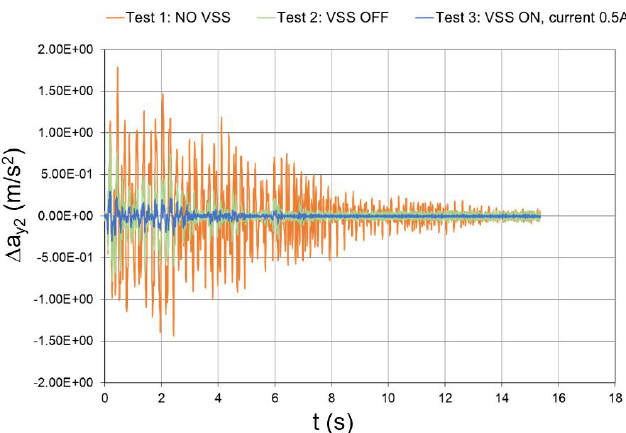
Figure 50. Seismic response (experimental data), interstory acceleration at the 2nd floor ( Δ 𝑎 y2 = 𝑎 y2 − 𝑎 y1 ).